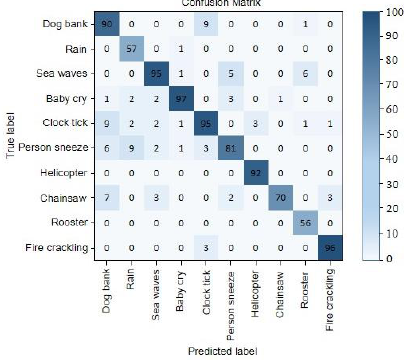
Figure 14. Confusion matrix for three datasets in